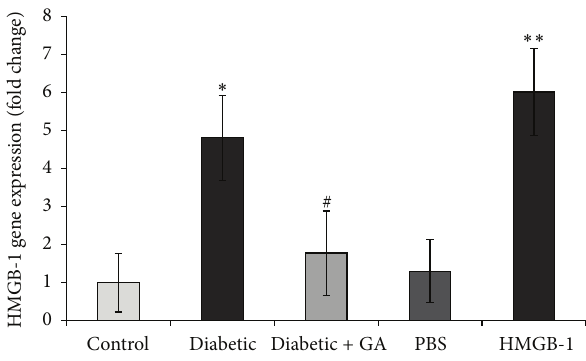
Figure 3: Gene expression of high-mobility group box-1 (HMGB1) in the retinas was quantified by RT-PCR using a primer given in the Materials and Methods section and was adjusted to the mRNA level of 𝛽 -actin in each sample. Each measurement was performed at least 3 times. Results are expressed as mean ± SD of at least 6 rats in each group. GA: glycyrrhizic acid; PBS: phosphate buffer saline ∗ 𝑃 < 0.05 compared with nondiabetic controlled rats. ∗∗ 𝑃 < 0.05 compared with PBS. # 𝑃 < 0.05 compared with diabetic